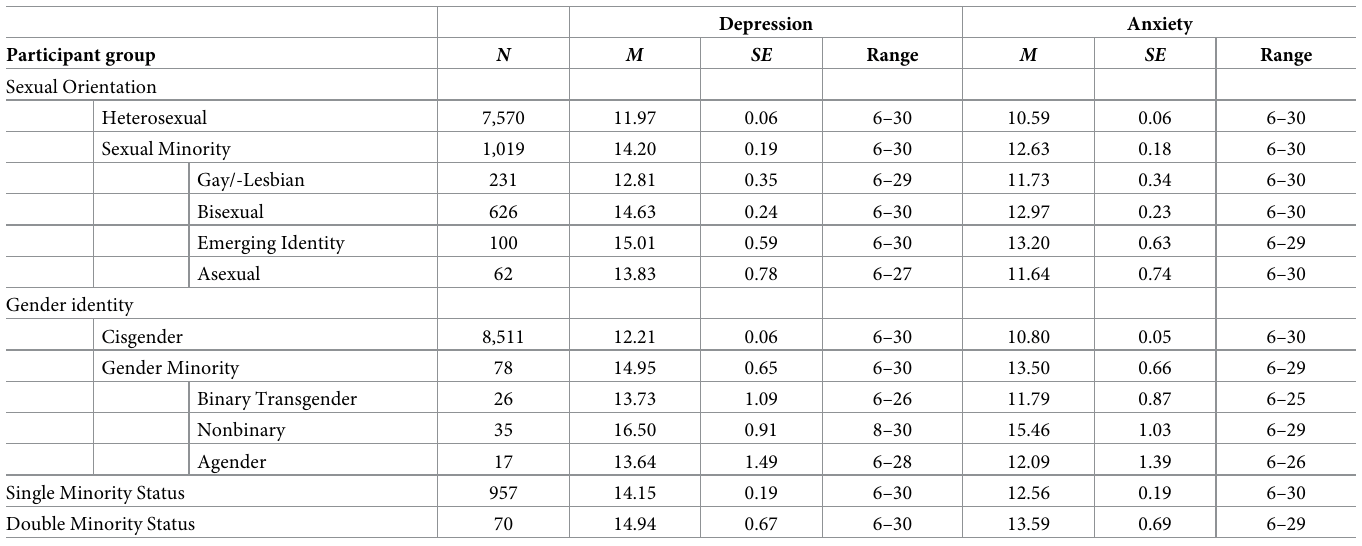
Table 2. Estimated marginal means for depression and anxiety.